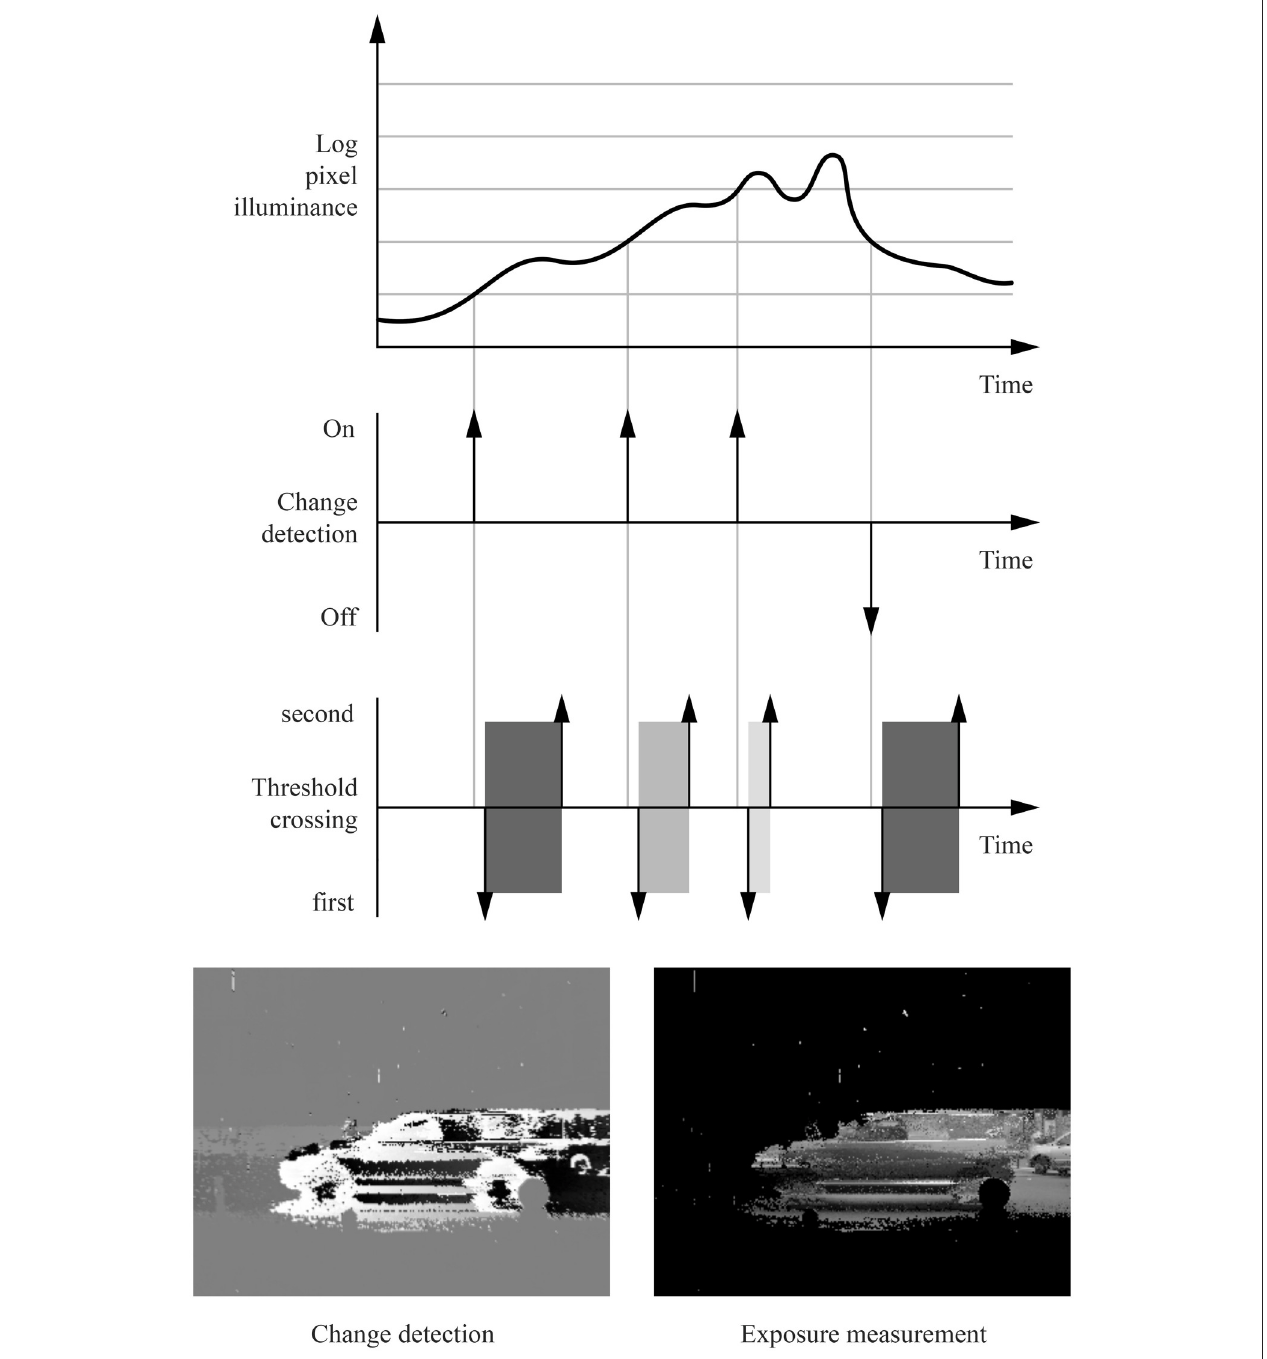
FIGURE 1 | The ATIS is an asynchronous, event-based camera with independent pixels. This figures illustrates the behavior of a single pixel. When the logarithm of the luminance captured by the pixel crosses a threshold, light integration for the pixel starts. The exposure measurement’s duration is proportional to the inverse of the luminance, and is notified by two events called threshold crossings: the first one is sent when the integration begins, the second one when it ends.